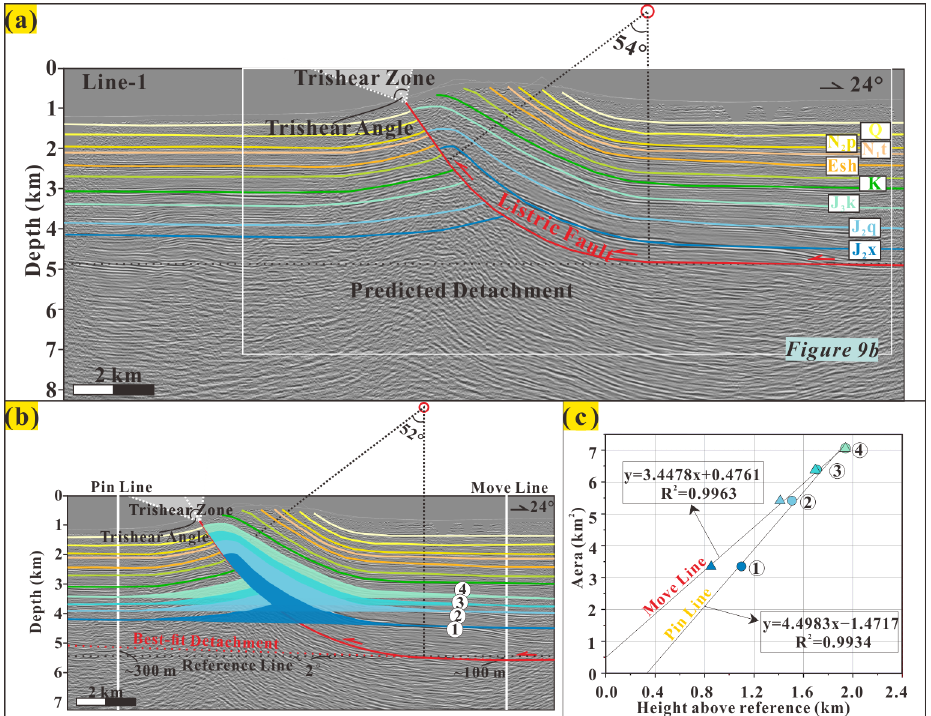
Figure 9. Seismic interpretation and ADS analysis of Line 1 (location in Figure 2a). ( a ) Interpretations of the seismic reflection profile. Vertical exaggeration is 1:1. ( b ) Areas and heights measured for horizons 1–4. ( c ) Area-depth diagram illustrating the area-depth relationships on both move lines and pin lines with R 2 values of